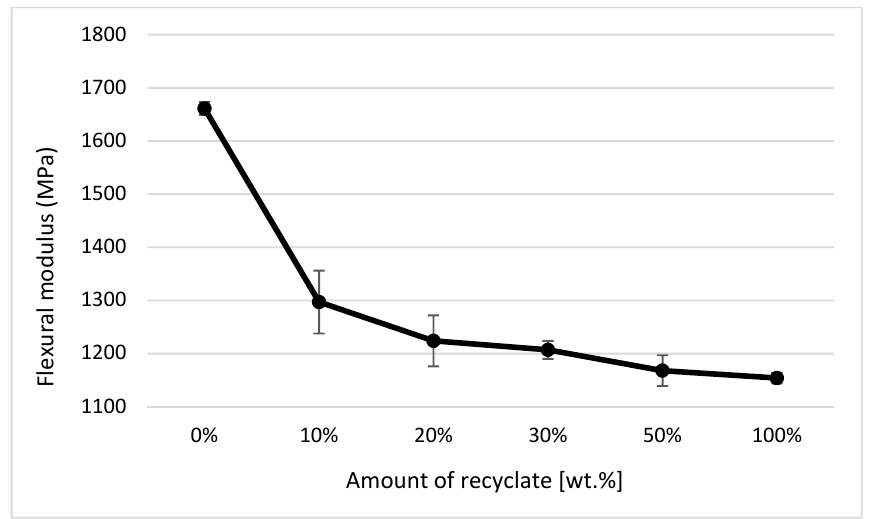
Figure 19. Dependence of the flexural modulus on the amount of recycled material before exposing the samples to elevated temperature.